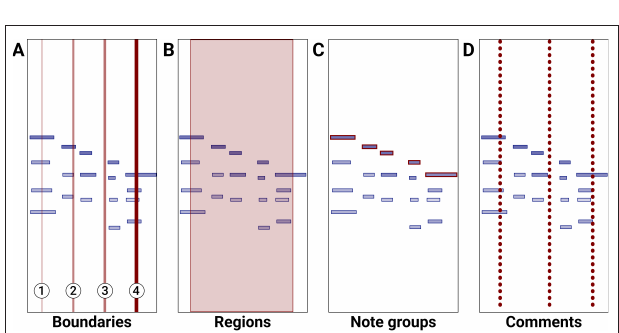
FIGURE 2 | CosmoNote’s four annotation types (shades of red) placed over the same sequence of notes (blue rectangles). (A) Four boundaries of different levels; (B) One region; (C) One note group containing five notes; (D) Three comments.